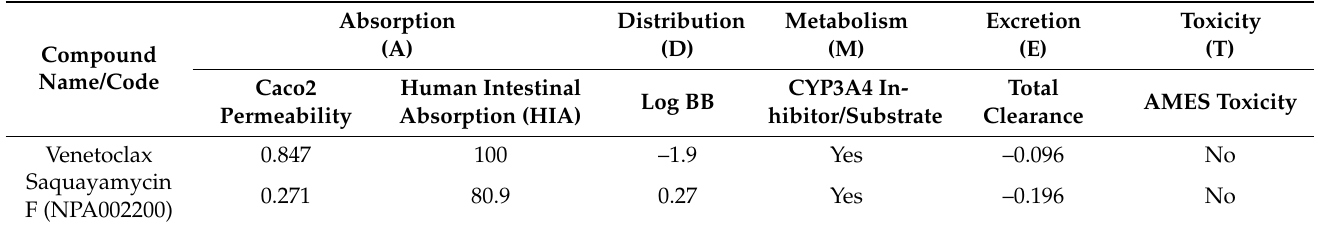
Table 4. The predicted ADMET characteristics for venetoclax and the saquayamycin F